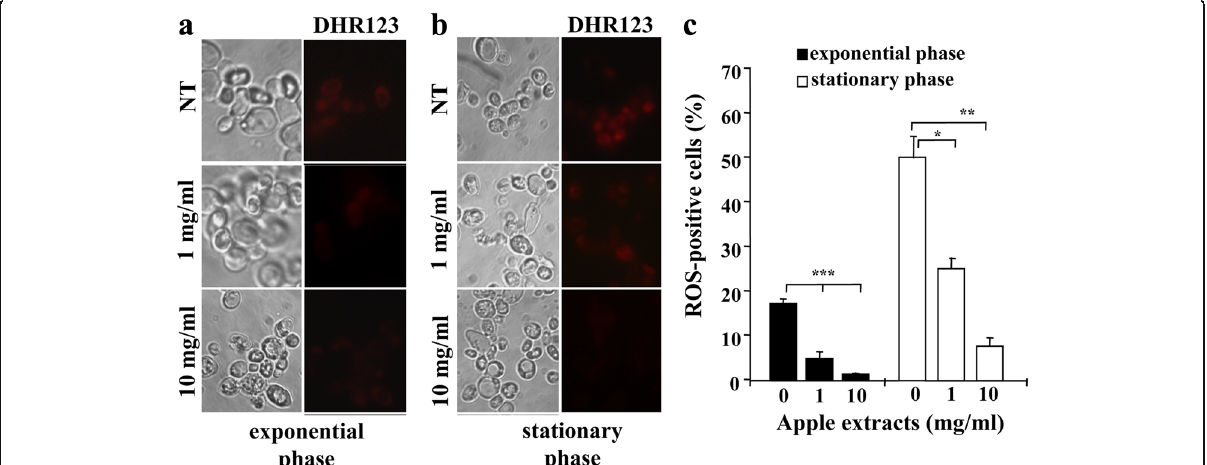
Fig. 2 Apple extracts reduce cellular ROS levels. Dihydrorhodamine 123 (DHR123) staining of the Kllsm4 Δ 1 cells during exponential ( a ) and stationary ( b ) phases in the absence (NT) and in the presence of apple extracts at the indicated concentrations. The left column represents phase contrast relative to DHR123 staining. Panel c represents the average percentage of ROS positive cells from three independent experiments. p -value: *<0.05; **<0.01; ***<0.001